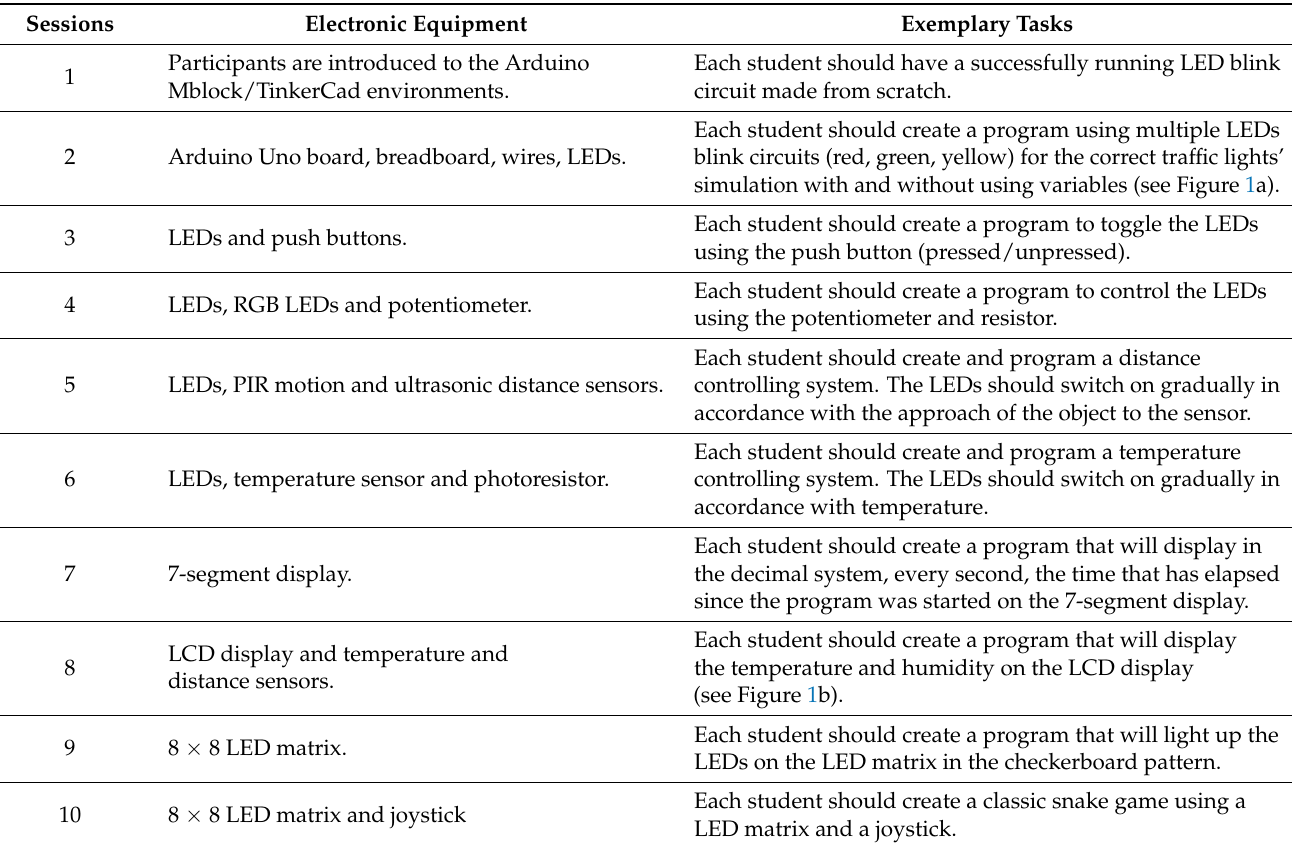
Figure 1. The illustration of students performing programming tasks in electronics courses in different learning modes ( a ) An example of the task from the second session using the distance form of extracurricular primary school education; ( b ) An example of the task from the eights session using the traditional form of extracurricular primary school education. Table 1. Course organization divided into